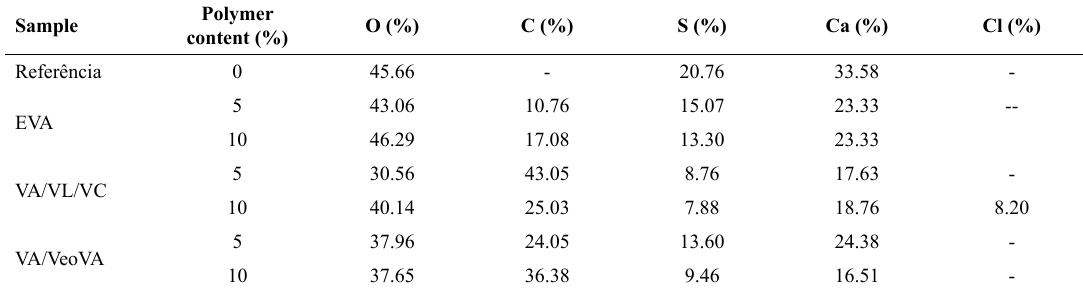
Table 2. Chemical composition of samples obtained by EDS.